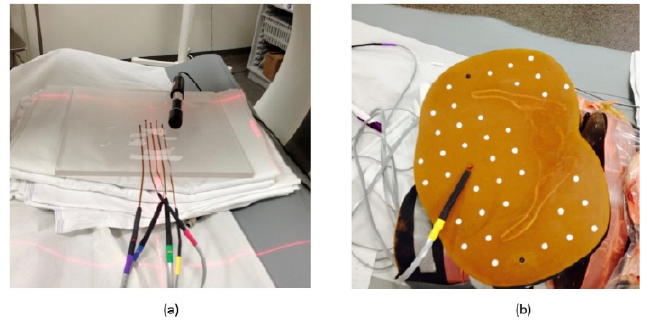
Figure 3. ( a ) MOSFET calibration with Radcal and ( b ) MOSFET detector insertion.